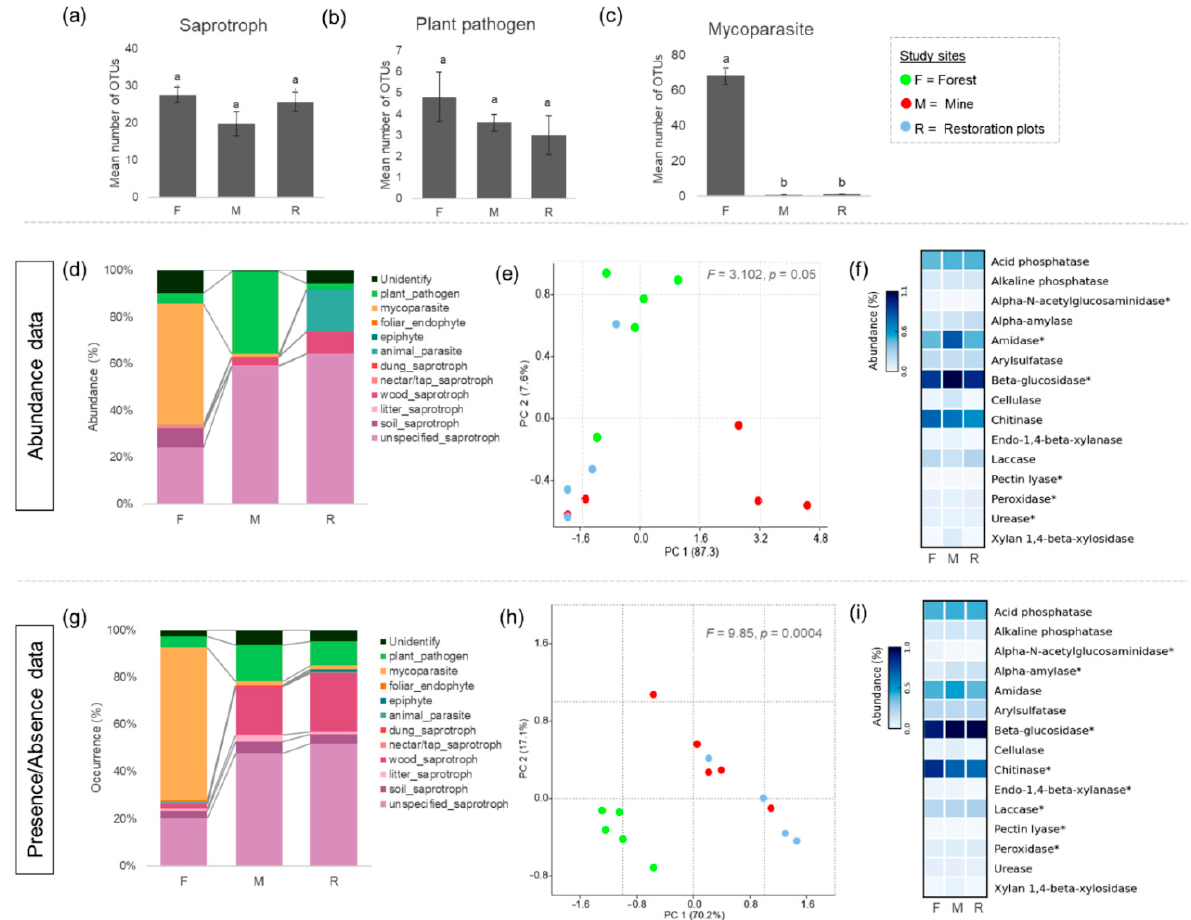
Figure 3. Functional profile predicted by FungalTraits and PICRUSt2. Bar plot shows the average number of OTUs ascribed to different fungal traits, including ( a ) Saprotroph ( b ) Plant pathogen and ( c ) Mycoparasites. Stack bar plots present fungal traits distribution among three study sites based on ( d ) abundance data and ( g ) presence/absence data. PCA ordinations show the composition of PICRUSt2-predicted enzymes based on ( e ) abundance OTU data and ( h ) presence/absence OTU data. The average number of 15 important soil enzymes based on ( f ) abundance OTU data and ( i ) presence/absence OTU data were shown in heatmap. Enzymes with asterisk present statistically significant ( p < 0.05). Different lowercase letters (a and b) indicate significant